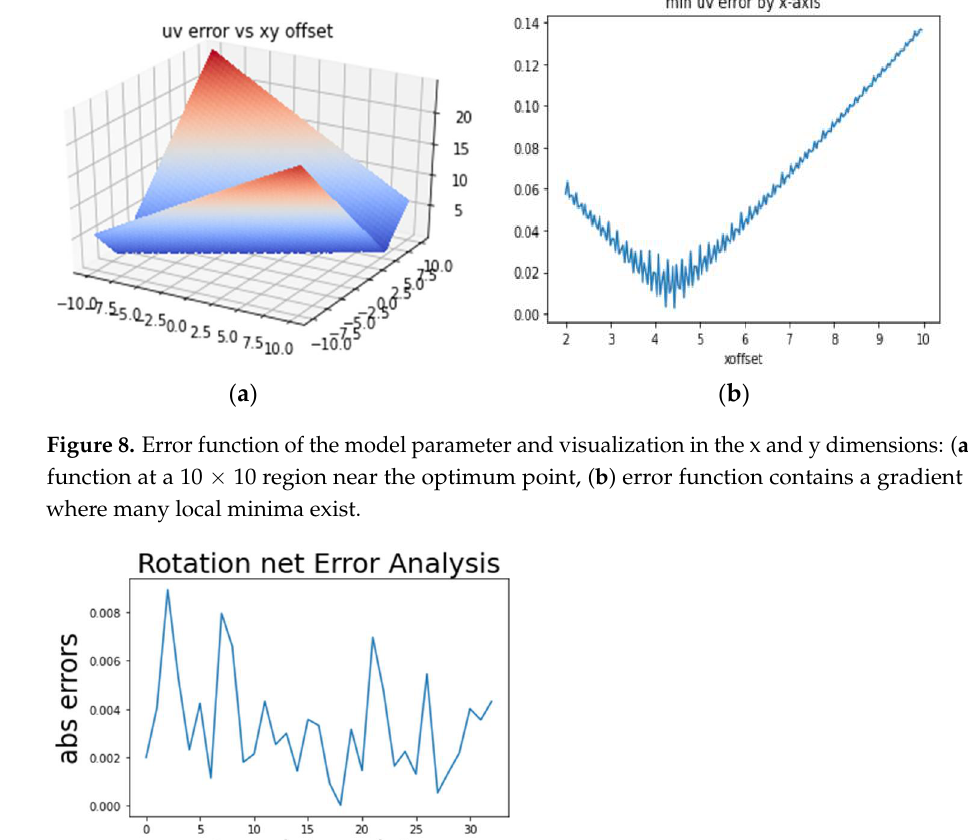
Table 1. Average location error predicted by the algorithm, grouped by target distance.